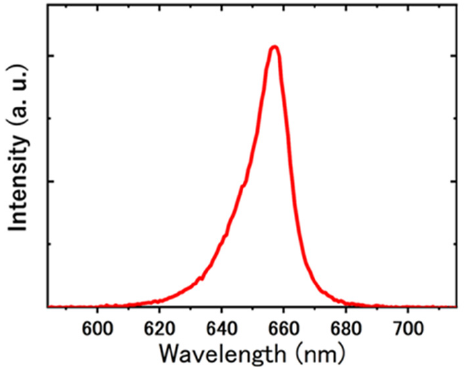
Figure 2. Luminescence spectrum of the red LED.